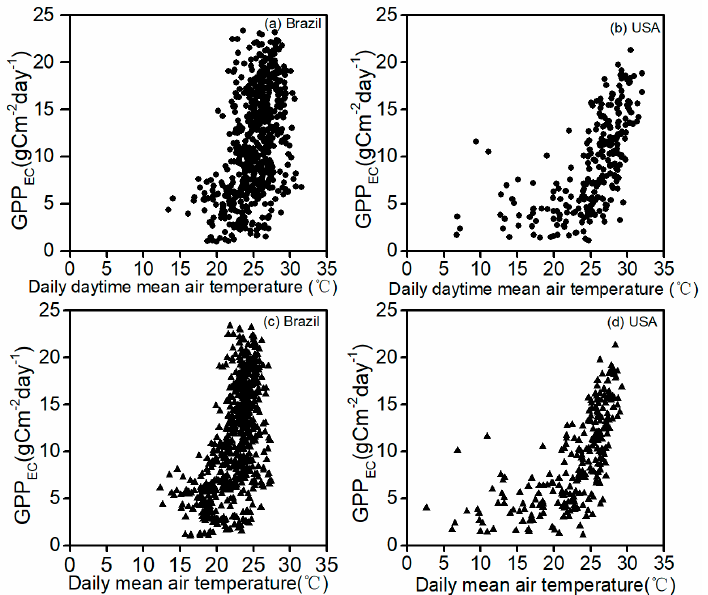
Figure 5. The relationships between the estimated gross primary production (GPP EC ), daily daytime mean air temperature, and daily mean air temperature within the sugarcane growing seasons at the two sugarcane EC tower sites. ( a ) and ( c ), Brazil site, 2005–2007; ( b ) and ( d ), Louisiana, USA site, 2017.